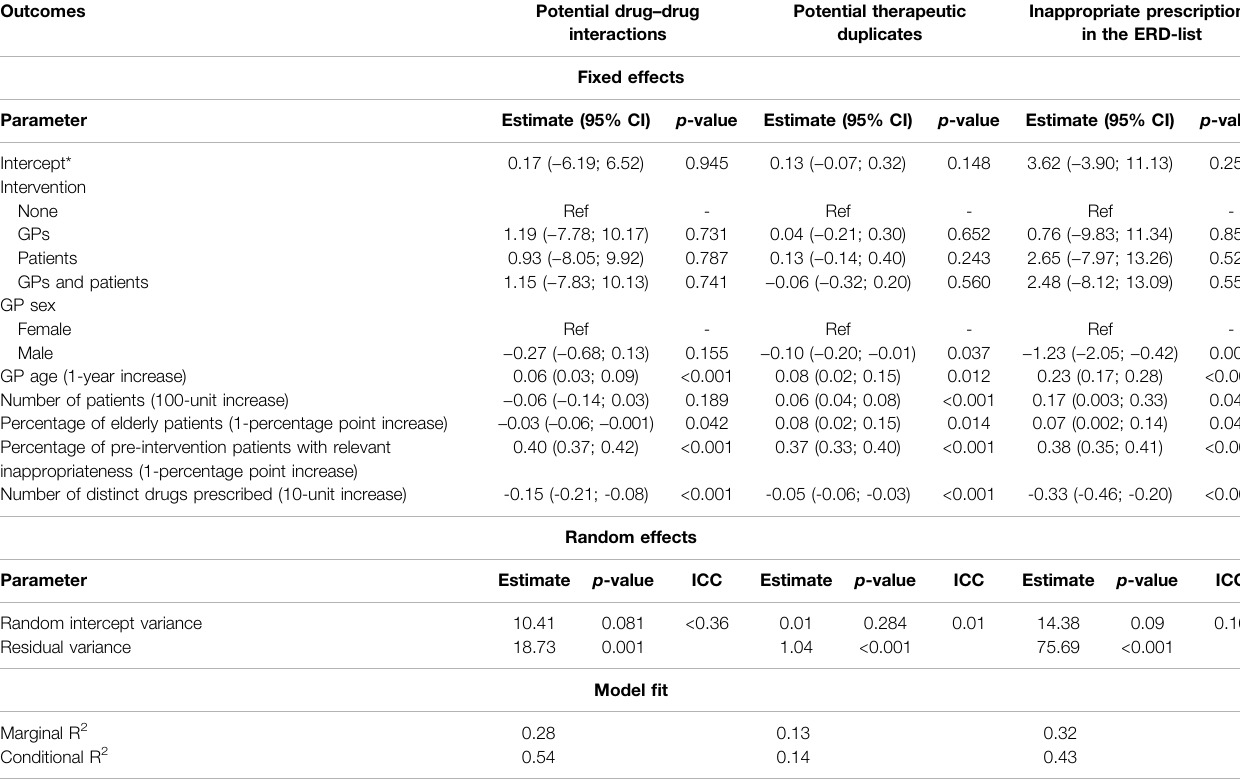
TABLE 3 | Linear random intercept model on pDDIs, pTDs, and ERD